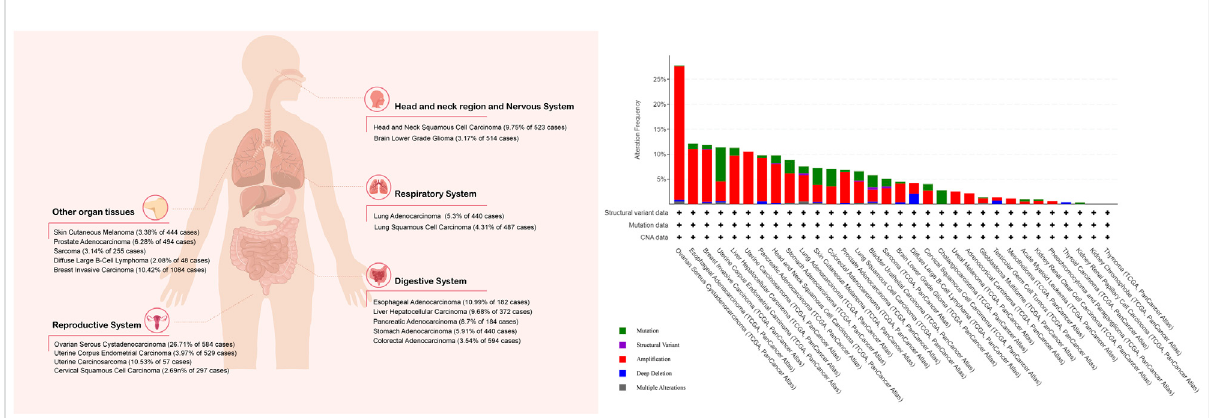
FIGURE 2 Percentage of tumor samples with increased FAK mRNA. The Cancer Genome Atlas was queried using the cBioPortal (cBioPortal for Cancer Genomics: PTK2 in Adrenocortical Carcinoma (TCGA, PanCancer Atlas) and 31 other studies). The search criteria included mRNA expression data (Z-scores for all genes) and tumor datasets with mRNA